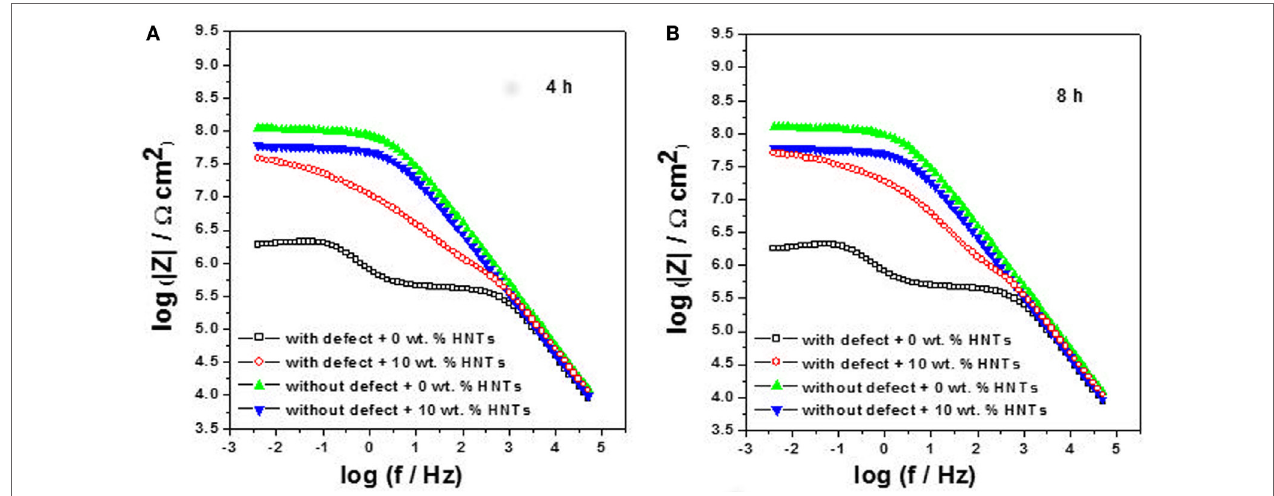
FigUre 8 | eis diagrams: Bode plots for carbon steel coated with alkyd primer doped with 0 wt.% and 10 wt.% of halloysite nanotubes obtained after 4 h (a) and 8 h (B) of immersion in 0.01 mol/l nacl .